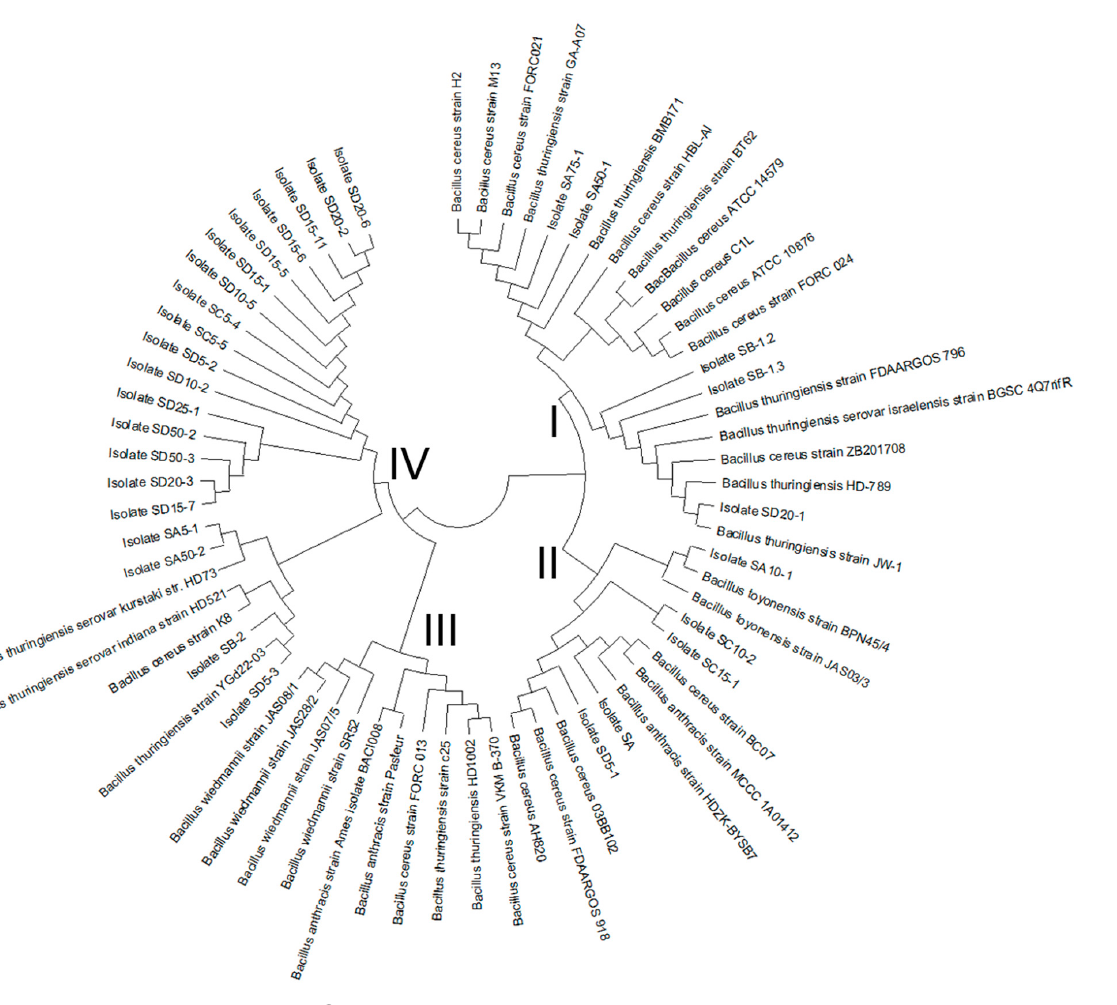
Figure 2. Phylogenetic analysis for tRNA Cys - yebC / pmpR region. The sequences of the isolates obtained from chili powder samples were compared with sequences of representative strains of B. cereus group. The isolated colonies obtained clustered within groups I, II, and IV, respectively (see Table 2 for correspondence of each isolate).